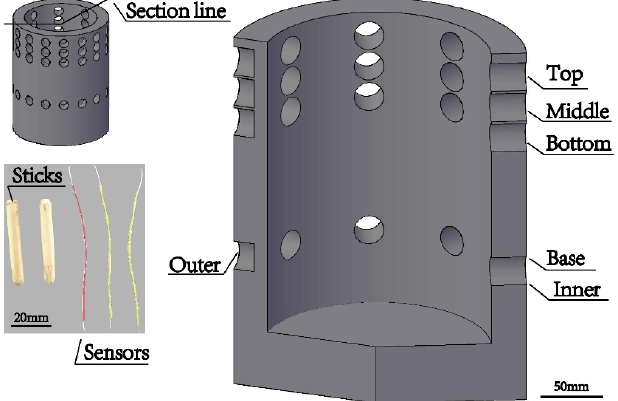
Figure 3. Schematic diagram of EMF mimicking blast furnace hearth and EMF sensors.